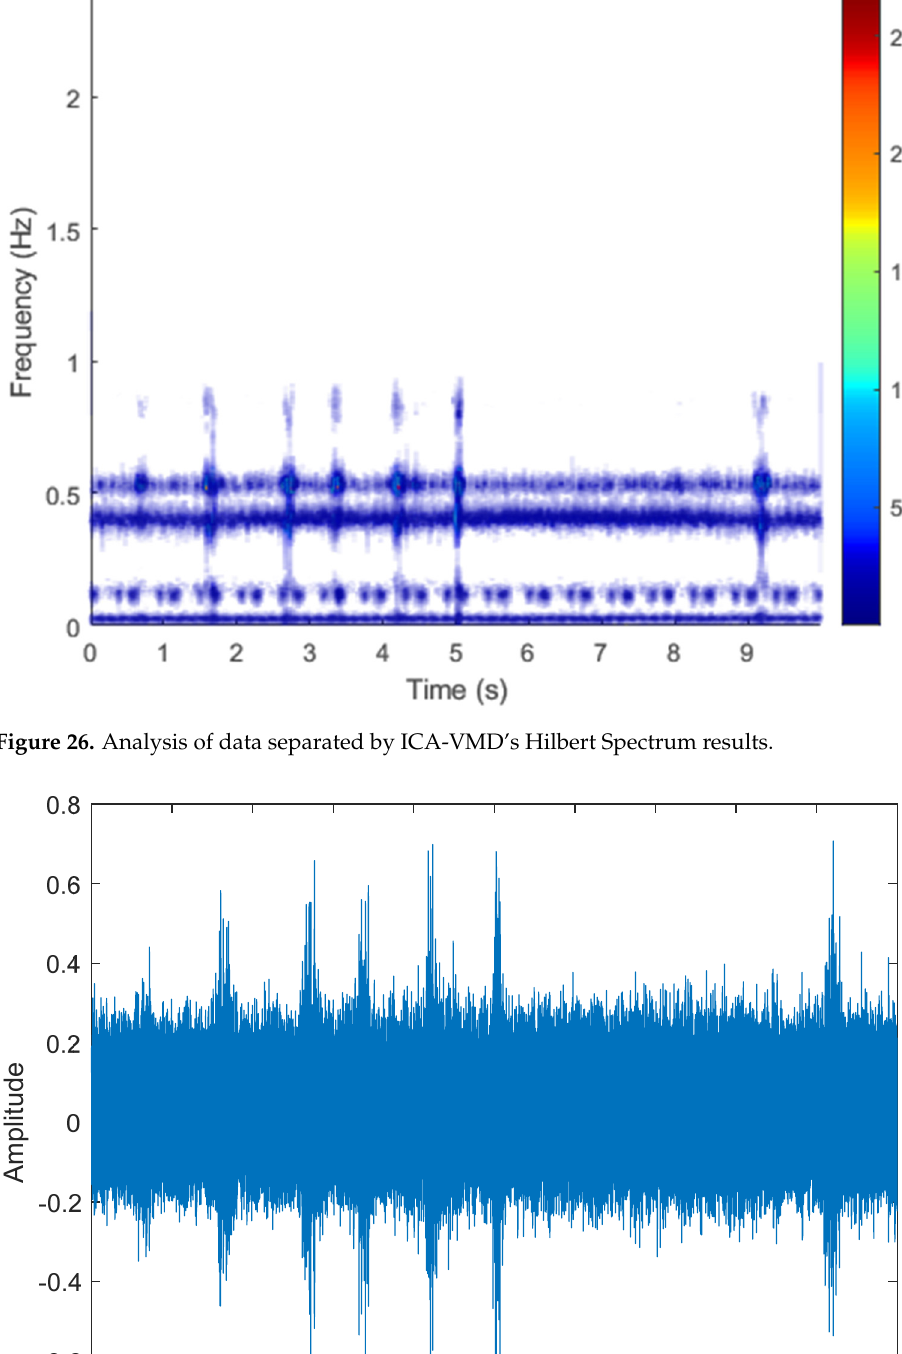
Figure 25. Analysis of data separated by ICA-VMD.